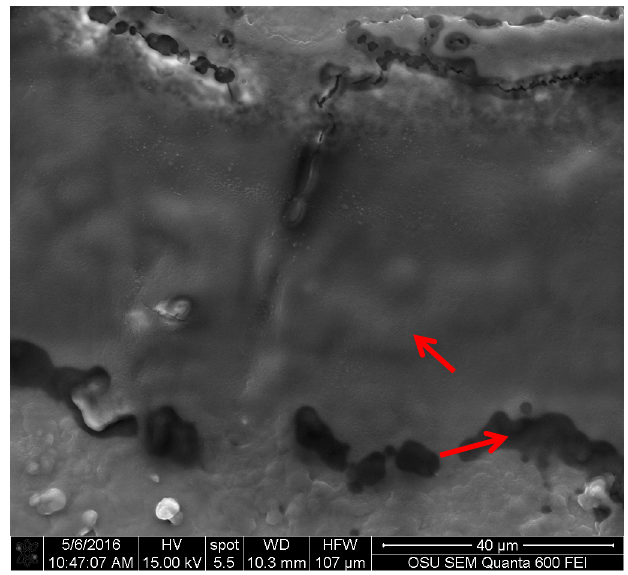
Figure 5. Extracted pigment of C. aeruginosa showing two reflective electron areas, pointed to with arrows. Picture taken with an FEI QUANTA 600 F.